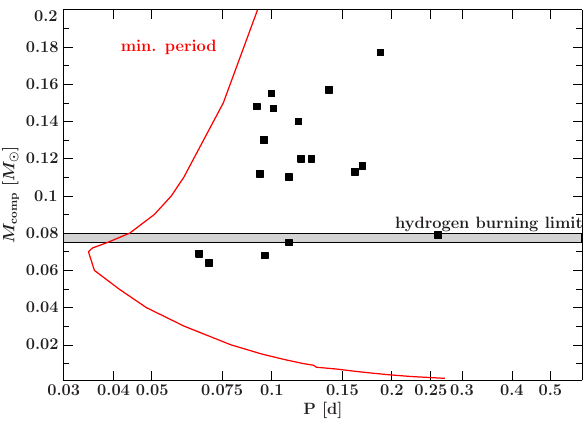
Figure 1. Period-companion mass diagram of the known HW Vir sys- tems. The gray area marks the hydrogen-burning limit. Companions with smaller masses are sub-stellar. The red, solid line gives the minimum period at which a companion of a certain mass can exist. This was calculated assuming that the companions cannot exceed its Roche